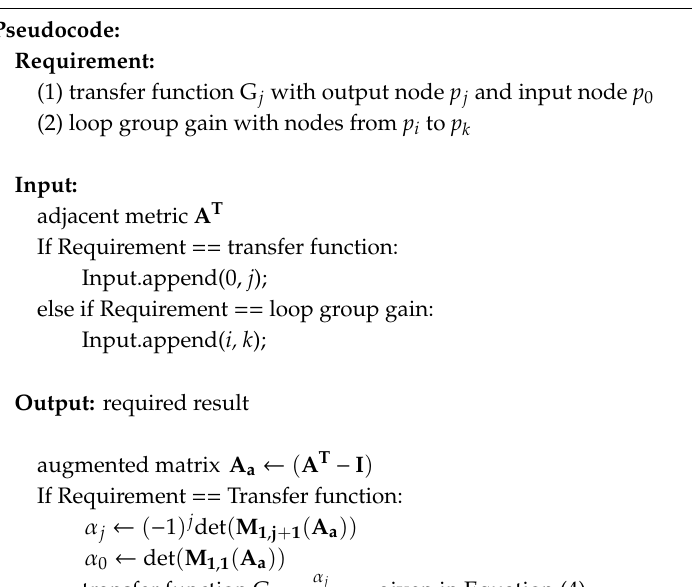
Algorithm 1. Transfer matrix method’s